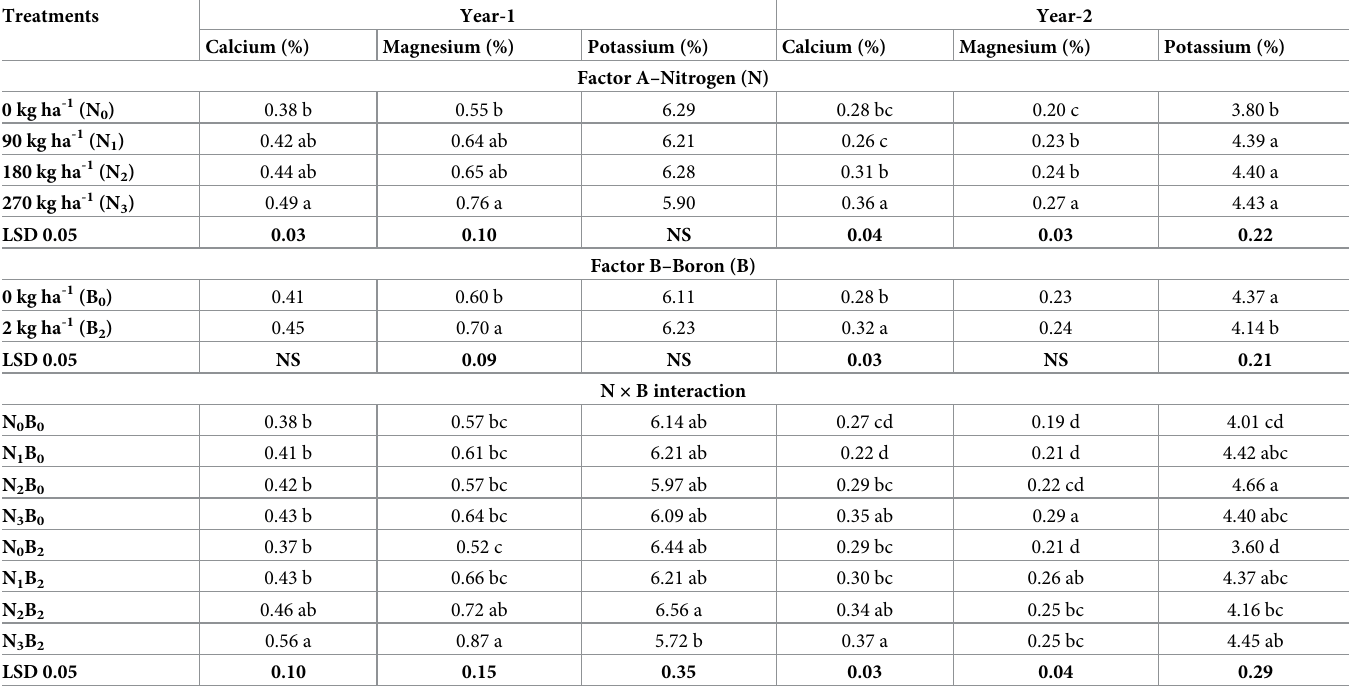
Table 2. The impact of different nitrogen and boron doses and their interaction on macro mineral contents in grafted watermelon rind. Treatments